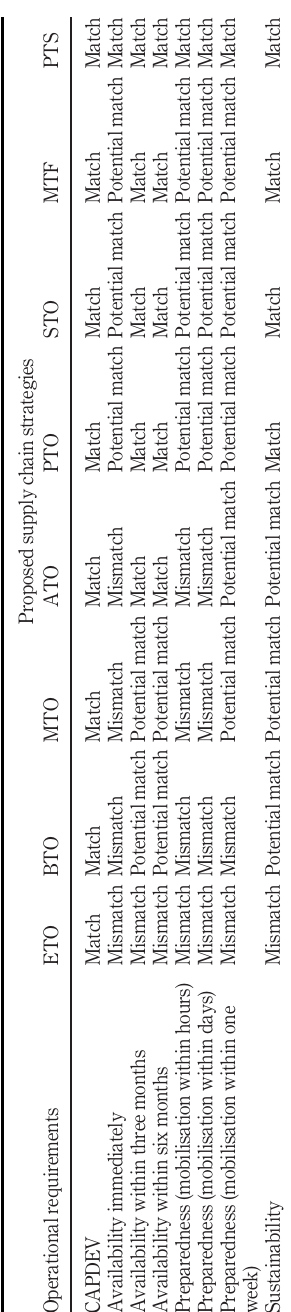
Table 5. Operational requirements versus proposed supply chain